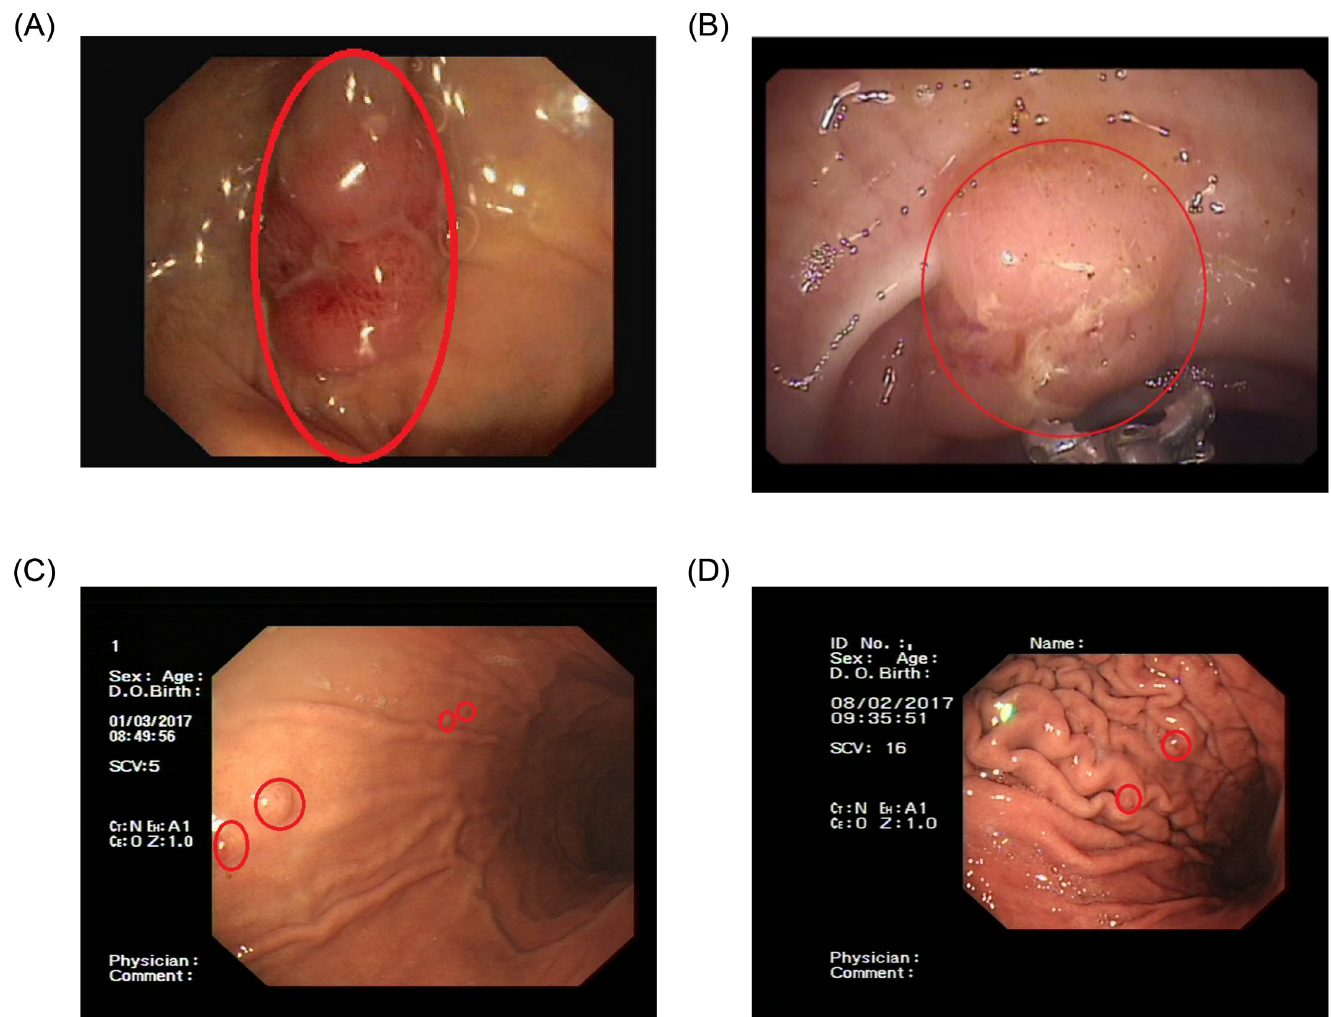
Fig 1. Comparison of colonic polyps and gastric polyps. The first two images ((A) and (B)) are images of colonic polyps. The next two images ((C) and (D)) are images of gastric polyps.